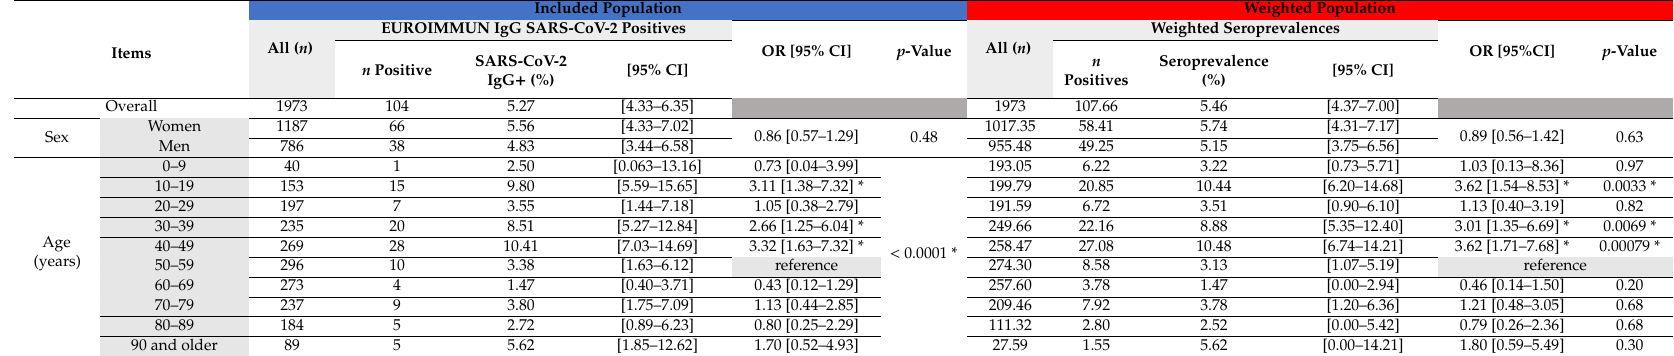
Table 1. Description of the population (included and adjusted) and univariate analysis of association with IgG anti-SARS-CoV-2 seropositivity ( p -value and odds ratio